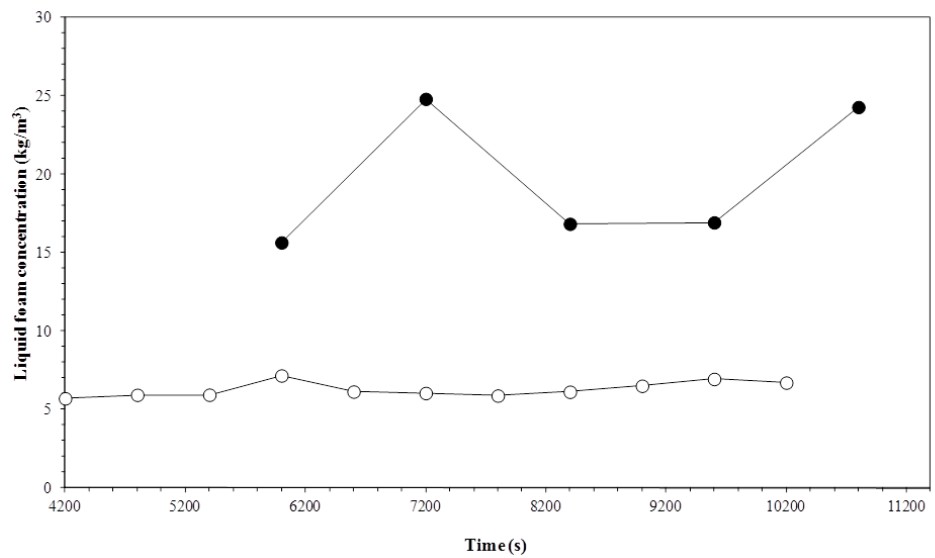
Figure 6. Variation in the liquid foam concentration with time and temperature. Experiment conditions: Initial biosurfactant concentration of 0.7 kg m − 3 and gas flow rate of 3.3 × 10 − 7 m 3 s − 1 . Temperatures: ( ○ ) 15 °C; ( ● ) 35 °C.